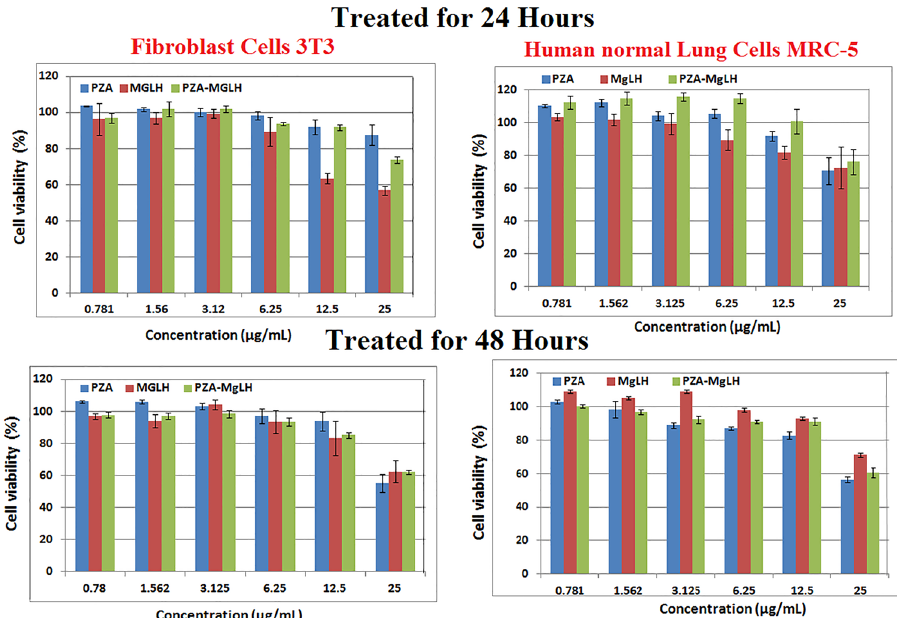
Figure 8. Viability of 3T3 fibroblast cells and MRC-5 human normal lung cells after 24 and 48 h of incubation. Data = mean ± SEM; N = 3; all values are statistically (p < 0.01) similar within each material formulation at each concentration, except for the MgLH at 12.5 μg/mL and higher against fibroblast